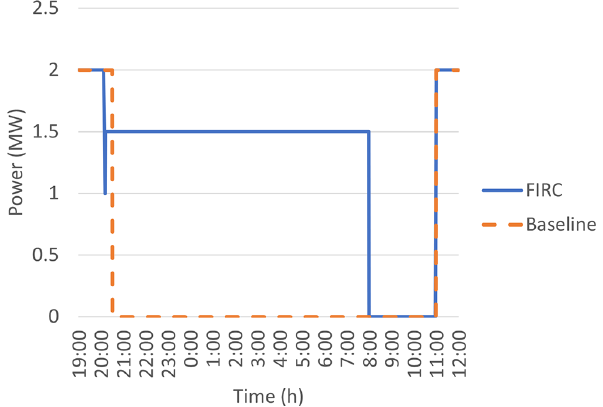
Figure 8. The FIRC derates the wind turbine to avoid a fault, in- creasing wind power plant production by 17MWh from time of high sensor readings to time of